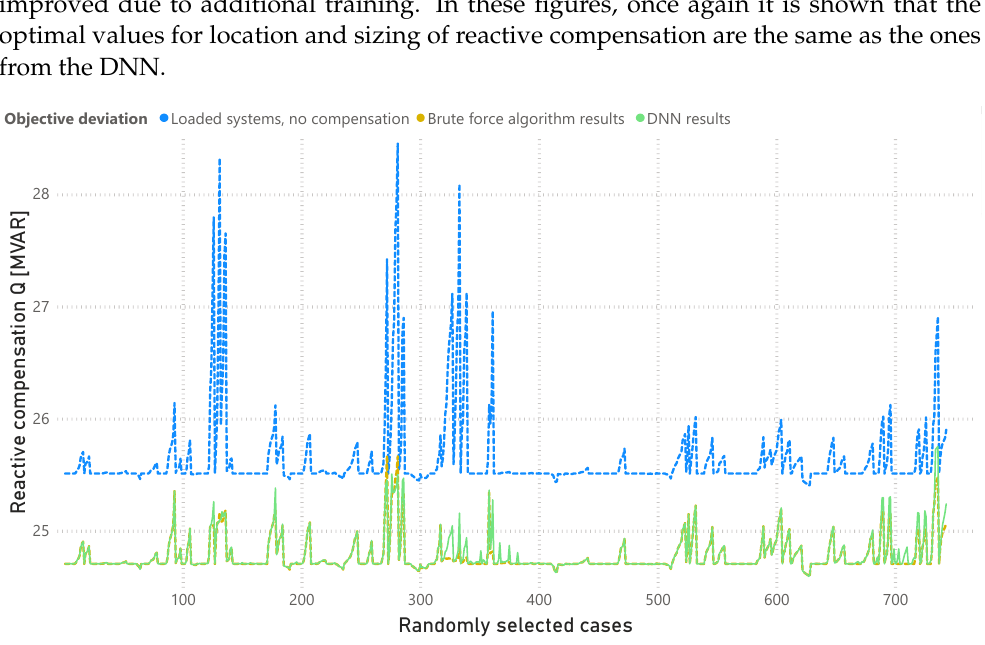
Figure 11. Objective deviations for 3575: original system, loaded system, brute force results and DNN results.